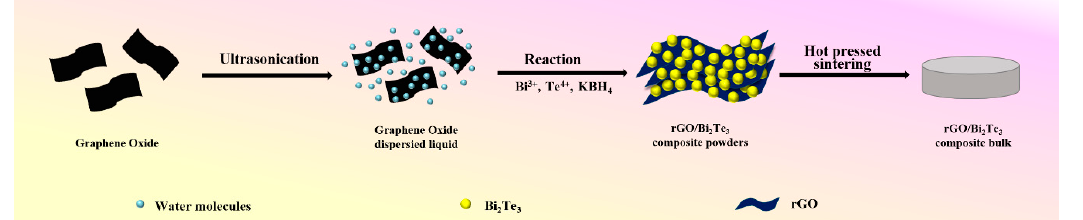
Figure 1. Preparation of rGO/Bi 2 Te 3 nanocomposite bulk materials.